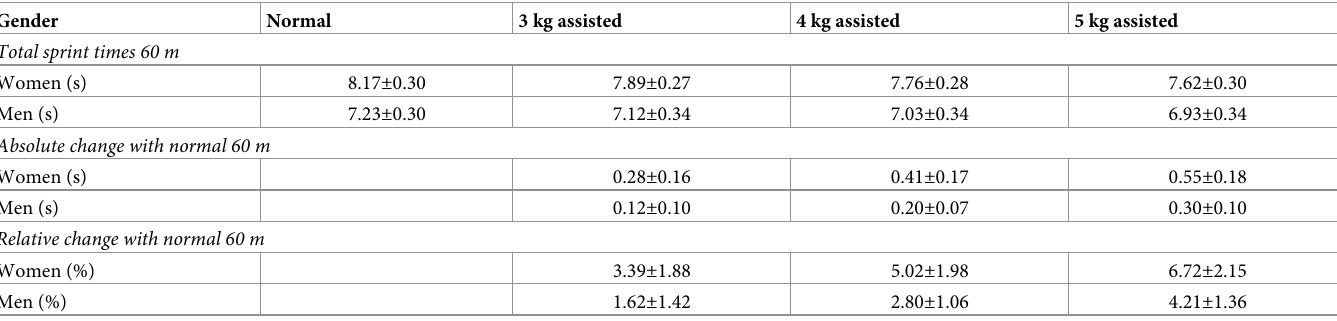
Table 1. Mean ( ± SD) sprint times and absolute and relative change in sprint times per gender.